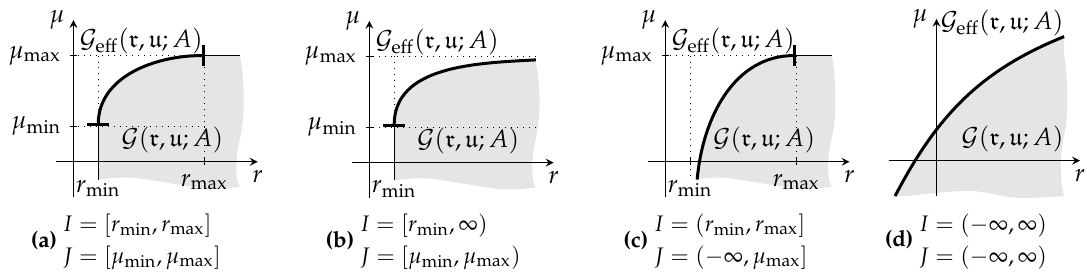
Figure 3. Illustration of efficient frontiers for different cases of the intervals I and J